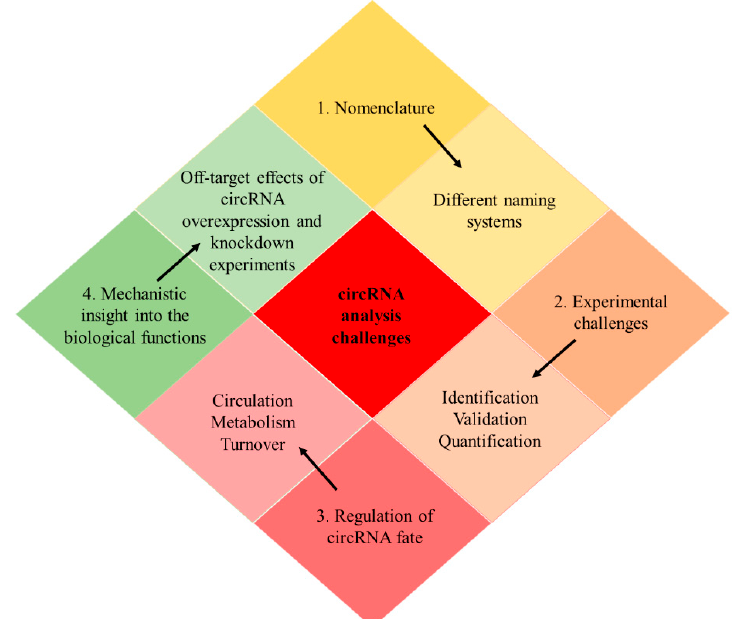
Figure 4. Main challenges in the field of circRNA analysis. Firstly, different nomenclature systems